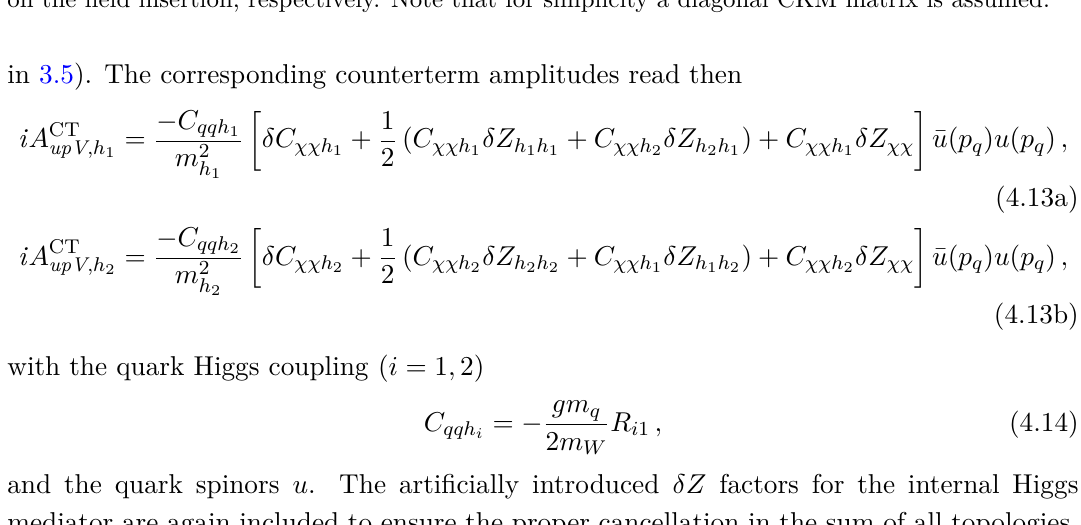
Figure 5 . The EW NLO corrections to the lower vertex. The indices i, j, k = 1 , 2 indicate the respective Higgs mediator h 1 , h 2 . The possible field insertions are given by Φ 1 = { G (0 , ± ) , Z, W ± } , Φ 2 = { h i , G (0 , ± ) , γ, Z, W ± } . The quark q 0 corresponds to the up- or down-type quark depending on the field insertion, respectively. Note that for simplicity a diagonal CKM matrix is